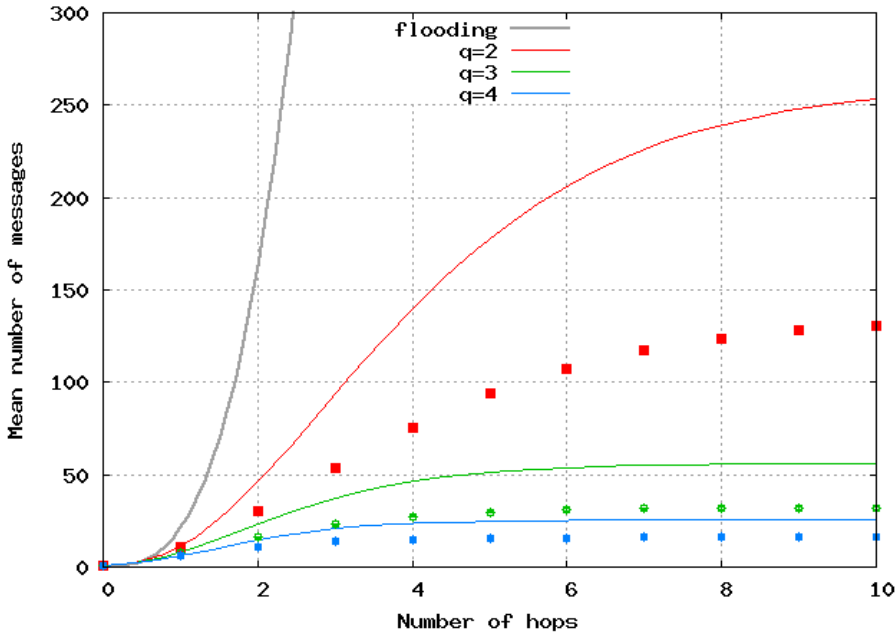
Figure 8. Mean number of messages sent sent per location update with respect to number of hops in 3D homogeneous